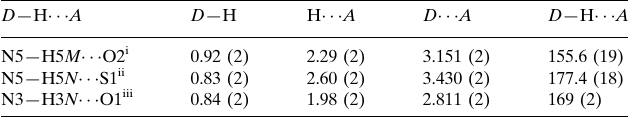
Hydrogen-bond geometry (A˚ , (cid:1)